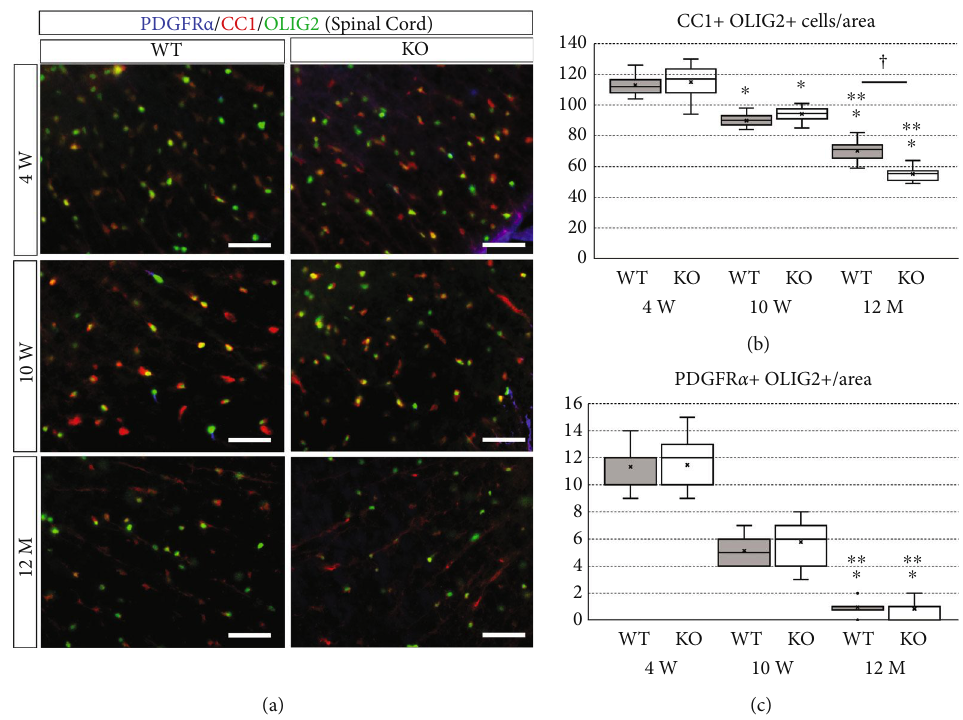
Figure 7: Immunostaining of oligodendrocytes and their progenitor cells in spinal cord sections. Wild-type (WT) and miR-23-27-24 cluster knockout (KO), n = 6 per group. (a) Sections of the spinal cord were immunostained for PDGFR α , a marker of oligodendrocyte progenitors, CC1, a marker of mature oligodendrocytes, and OLIG2, a broad marker of oligodendrocytes. Scale bars: 50 μ m. (b) Number of mature oligodendrocytes showing double positivity for CC1 and OLIG2. The number of mature oligodendrocytes signi fi cantly decreased with age in both WT and KO mice. The number of mature oligodendrocytes in KO mice was signi fi cantly lower than that in WT mice only at 12 months of age. ∗ Compared to 4-week-old. ∗∗ Compared to 10-week-old. † Comparison between WT and KO mice, p < 0 : 05 . (c) Number of oligodendrocyte progenitors showing double positivity for PDGFR α and OLIG2. The number of oligodendrocyte progenitors at 12 months of age was signi fi cantly lower compared to that at 4 and 10 weeks of age in both WT and KO mice. However, there was no signi fi cant di ff erence in the number of oligodendrocyte progenitors between WT and KO mice at all ages. ∗ Compared to 4-week-old. ∗∗ Compared to 10-week-old, p < 0 : 05